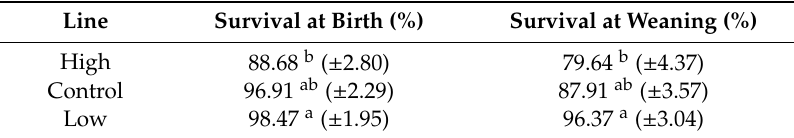
Table 5. Di ff erences in survival at birth and at weaning and standard errors (in brackets) between